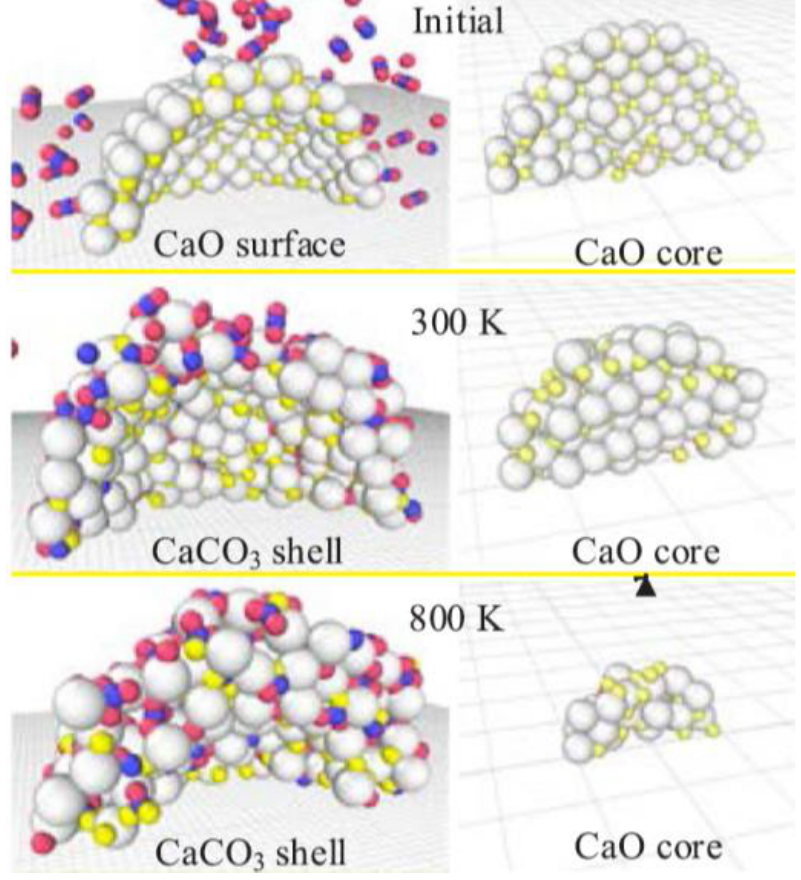
Figure 1. Snapshots of CaCO